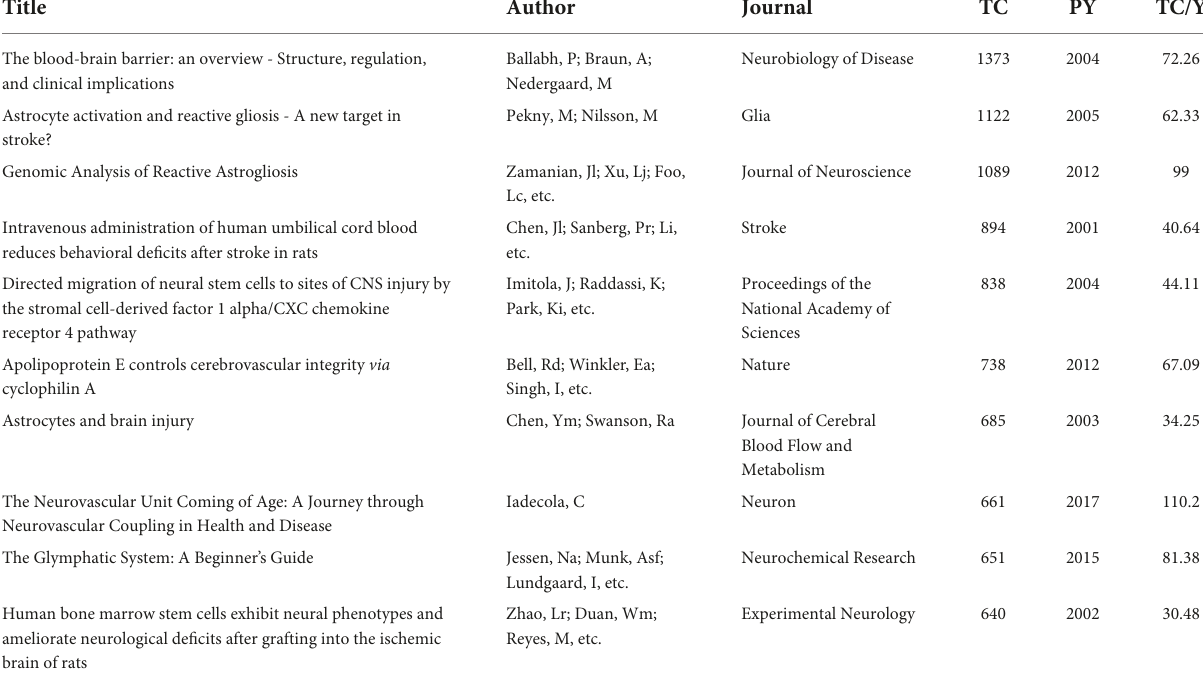
TABLE 4 Top 10 most cited papers in the field of stroke and astrocyte during